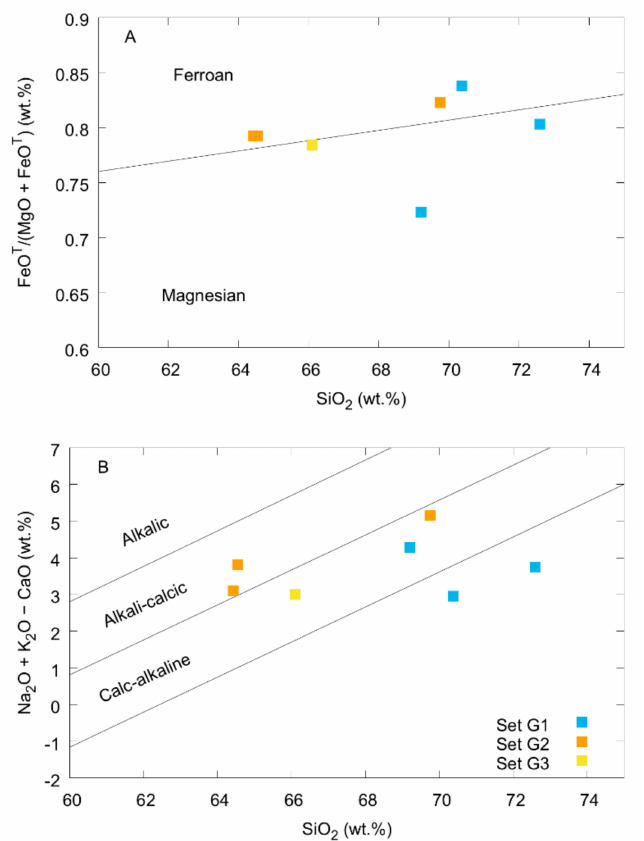
Figure 12. Classification of the granitoid samples in this study using the scheme of [28]. The granitoids varied between magnesian and ferroan ( A ) and ranged from calc-alkaline to alkali-calcic, but were not alkalic ( B